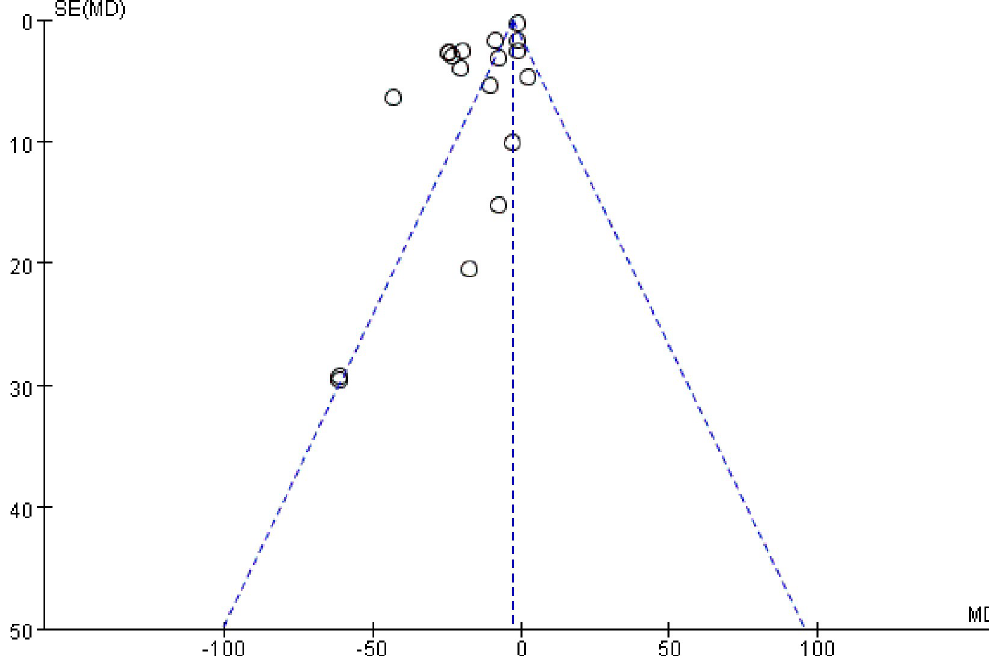
Fig 7. Funnel plot for the publication bias of SCr.